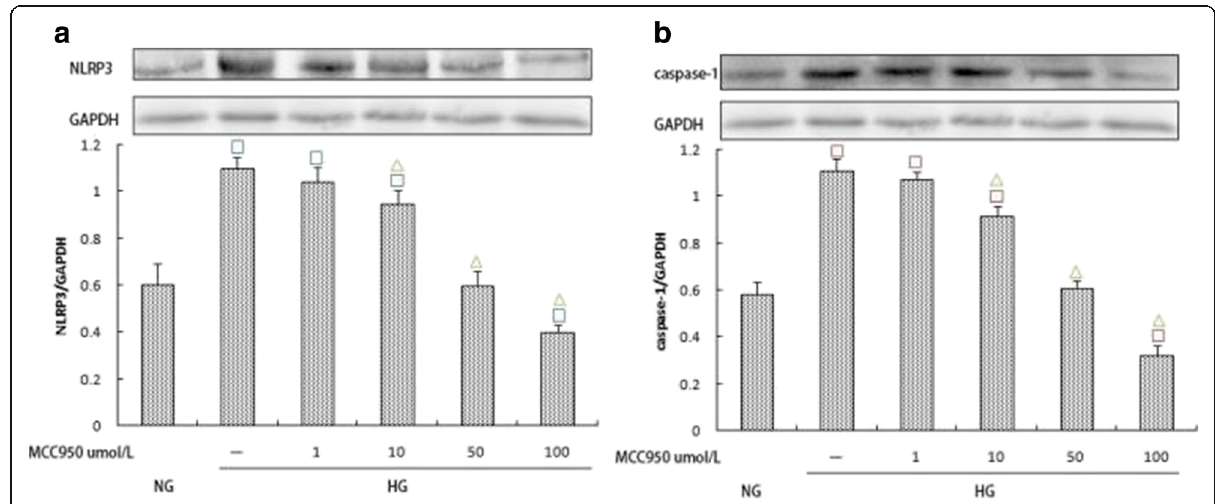
Fig. 5 a , b Effects of varying MCC950 concentrations (0,1,10,50 and 100 μ mol/L) on NLRP3 and Caspase-1 expression within the high glucose group. The protein was measured by western blotting.GAPDH was used as an internal loading control. NG:normal control group,HG:high glucose group.Data are presented in mean ± SD, □ P < 0. 05 versus normal control group, △ P < 0. 05 versus high glucose